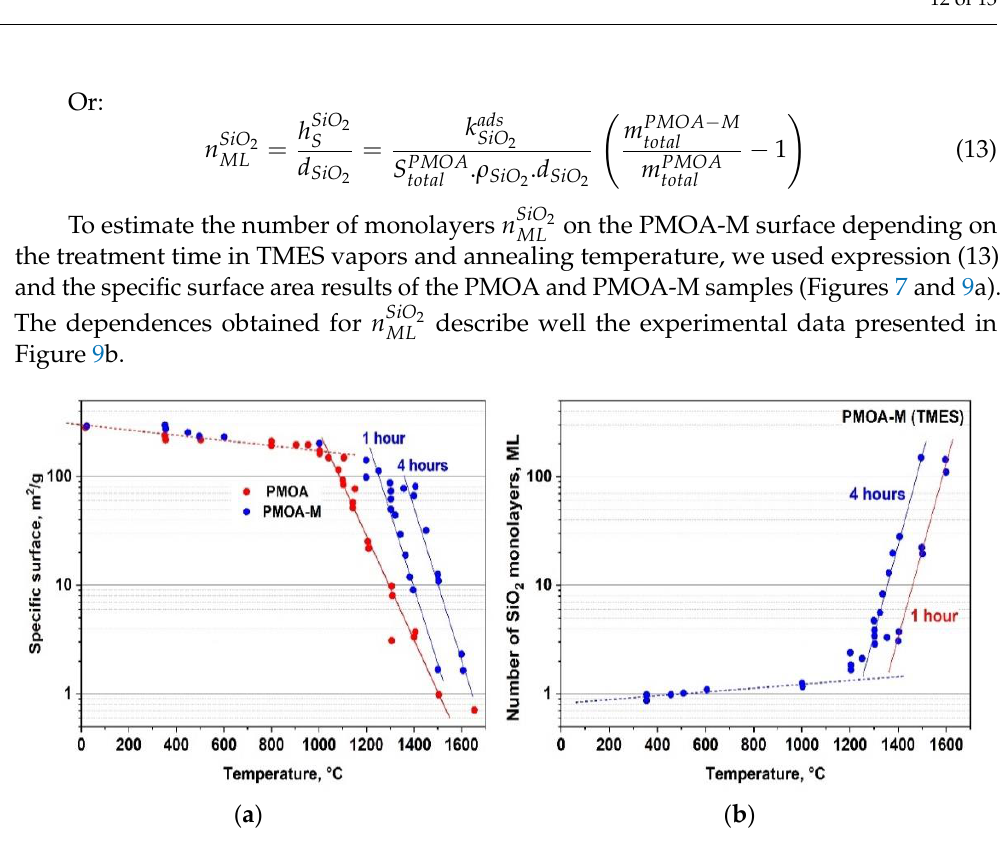
Figure 9. PMOA samples exposed for 1h and 4h to MTM vapor and annealed at the temperatures of 350 – 1600 °C: ( a ) specific surface variations and ( b ) the thickness of SiO 2 layer on the fibril surfaces.